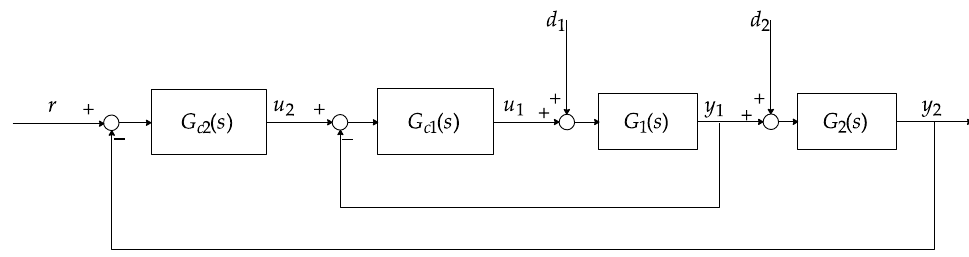
Figure 2. The block diagram of SST cascade control system.